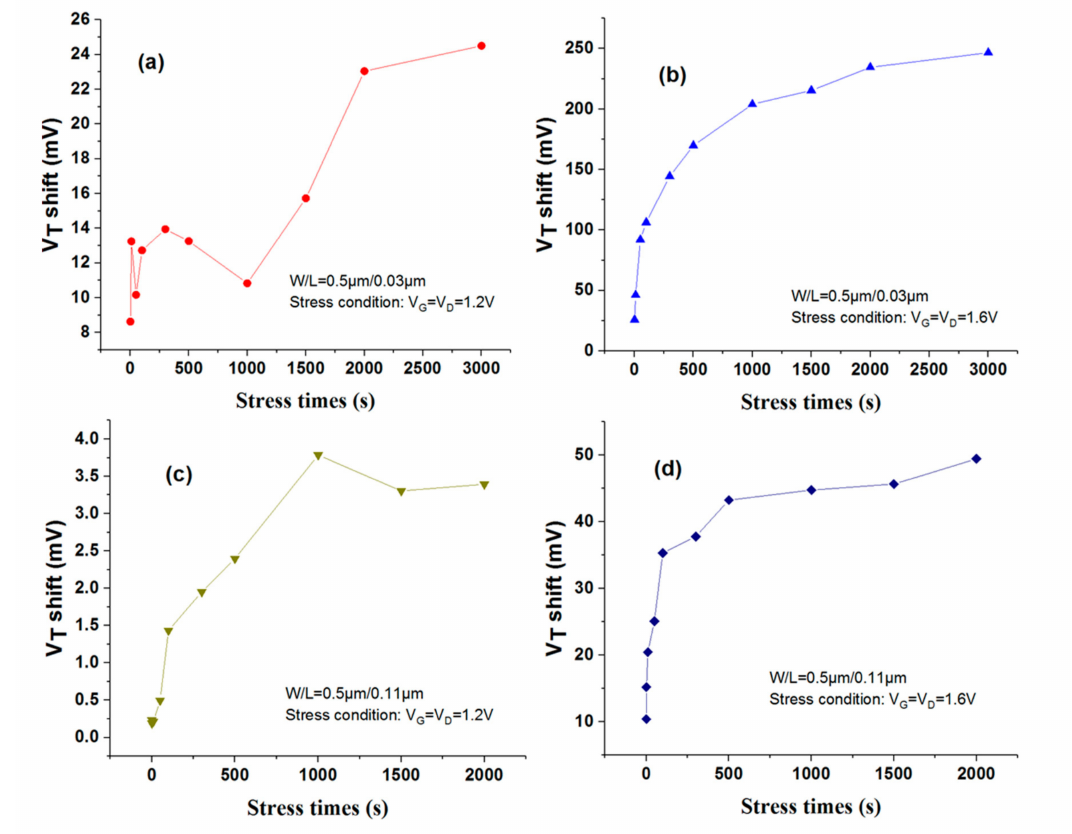
Figure 6. In CHC test conditions, the V T shift at: ( a ) W / L = 0.5 / 0.03 µ m / µ m, stressed at V GS = V DS = 1.2 V, ( b ) W / L = 0.5 / 0.03 µ m / µ m, stressed at V GS = V DS = 1.6 V, ( c ) W / L = 0.5 / 0.11 µ m / µ m, stressed at V GS = V DS = 1.2 V, and ( d ) W / L = 0.5 / 0.11 µ m / µ m, stressed at V GS = V DS = 1.6